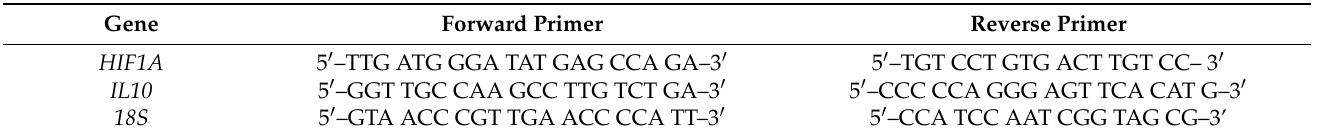
Table 1. Pair of primers used to amplify human genes by